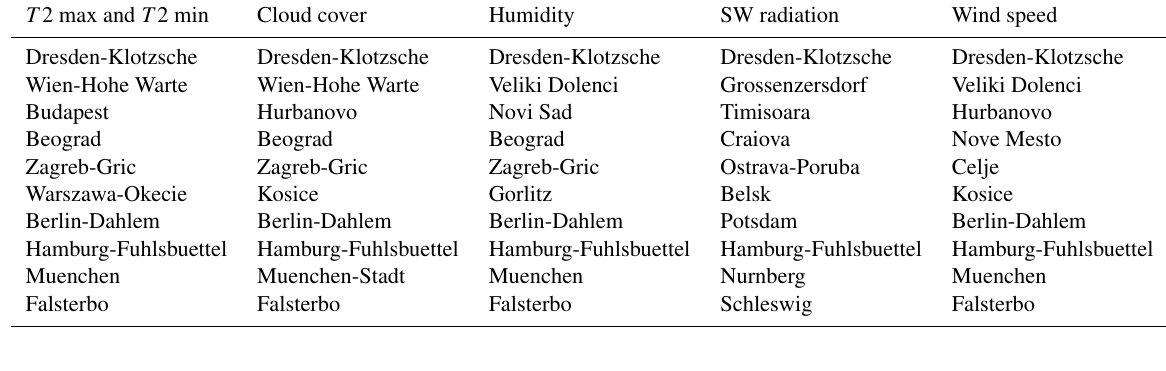
Table 3. Stations used from ECAD for specific variables. T 2 max and T 2 min